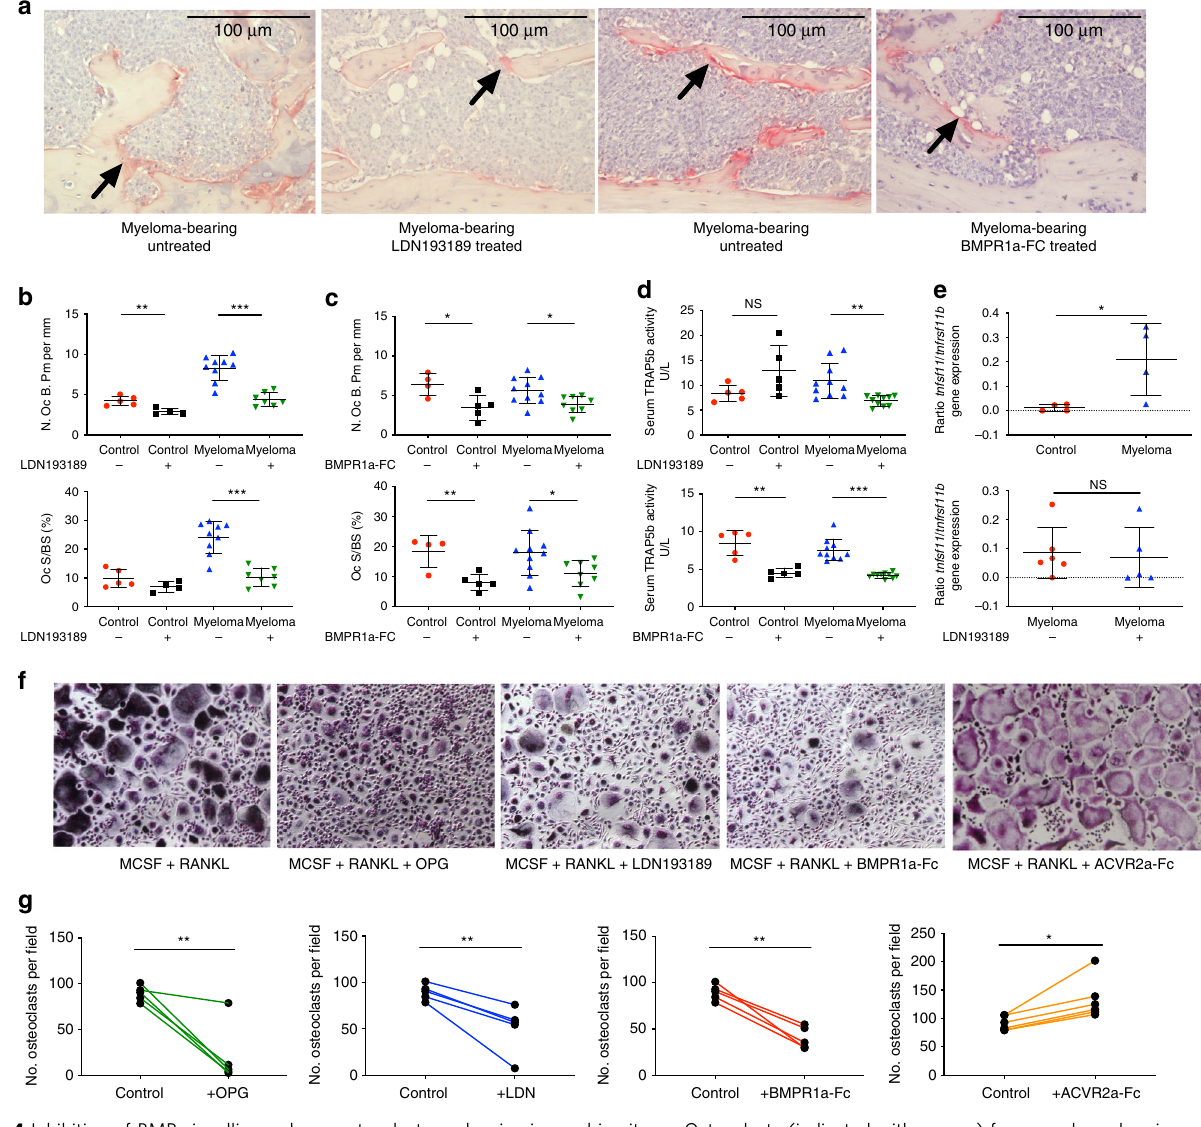
Fig. 4 Inhibition of BMP signalling reduces osteoclast number in vivo and in vitro. a Osteoclasts (indicated with arrows) from myeloma-bearing mice: vehicle vs. LDN193189 treated and vehicle vs. BMPR1a-FC treated (TRAP and haematoxylin-stained). Scale bar = 100 μ m. b , c Histomorphometric analysis of TRAP-stained osteoclast bone surface density (N.Oc.B.Pm) and osteoclast surface/ trabecular surface ratio (OcS/BS) in healthy and myeloma-bearing mice. n = 5 per control group, 10 per myeloma group and total n = 30. Missing data values: see Methods. b Vehicle vs. LDN193189 treated. c Vehicle vs. BMPR1a-FC treated. d Serum TRAP-5b concentration, indicating global osteoclast burden, in vehicle vs. LDN193189-treated and vehicle vs. BMPR1a-FC treated healthy and myeloma-bearing mice. e RNA-Seq-generated in vivo Tnfsf11 : Tnfrsf11b (RANKL to OPG) expression in osteoblasts. Ratio in healthy vs. myeloma-bearing mice and vehicle vs. LDN193189-treated myeloma-bearing mice. f Pooled human CD14 + PBMC osteoclast differentiation, with treatments as indicated commenced 24 h after seeding, and TRAP-stained at day 10. Images were taken at ×70 magni fi cation. g Quanti fi ed osteoclasts ( ≥ 3 nuclei) when CD14 + PBMCs treated as f were enumerated. Results from same experimental replicate are paired to account for inter-replicate variation ( n = 5 replicates, paired t test). * P < 0.05, ** p < 0.01, *** p < 0.001, NS, not signi fi cant, t test. Data represent mean ±